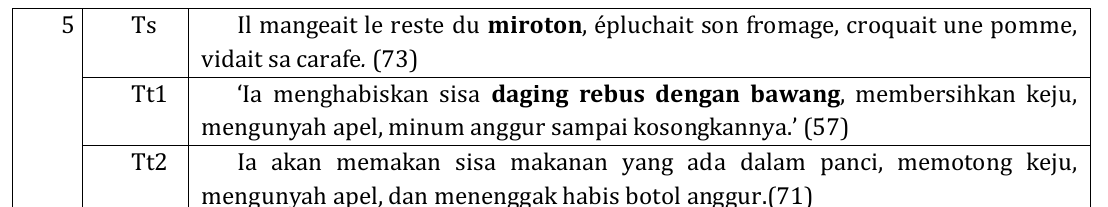
Tableu 5 L’addition paraphrastiqu e